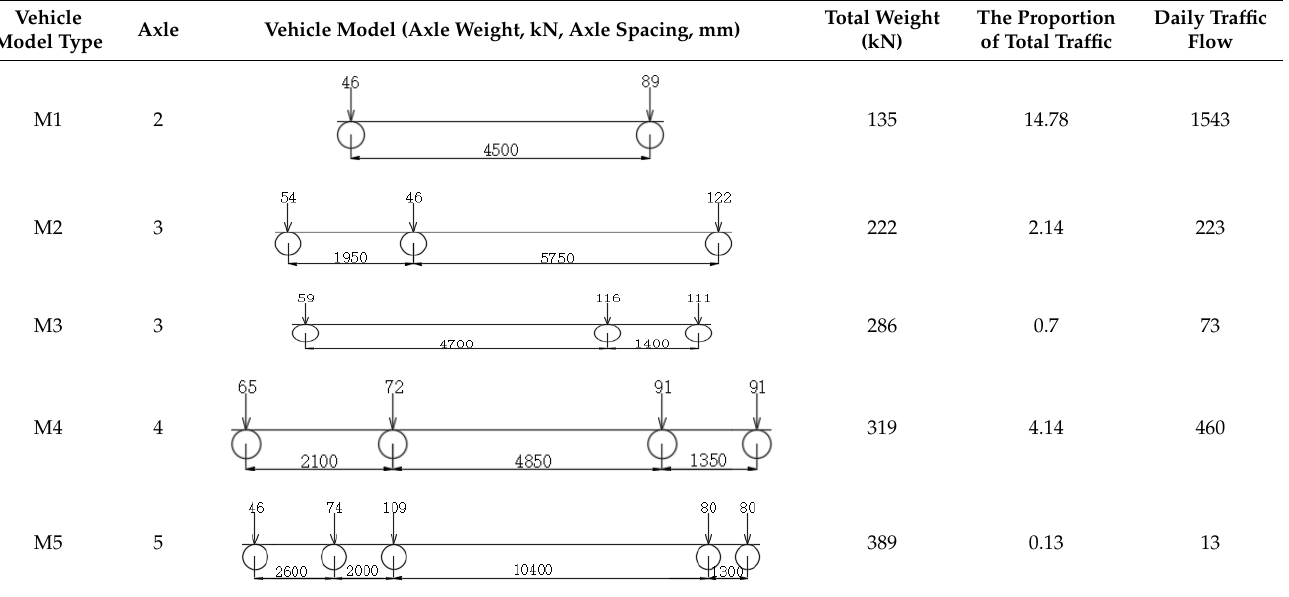
Table 4. Fatigue traffic model and traffic flow statistics [28].